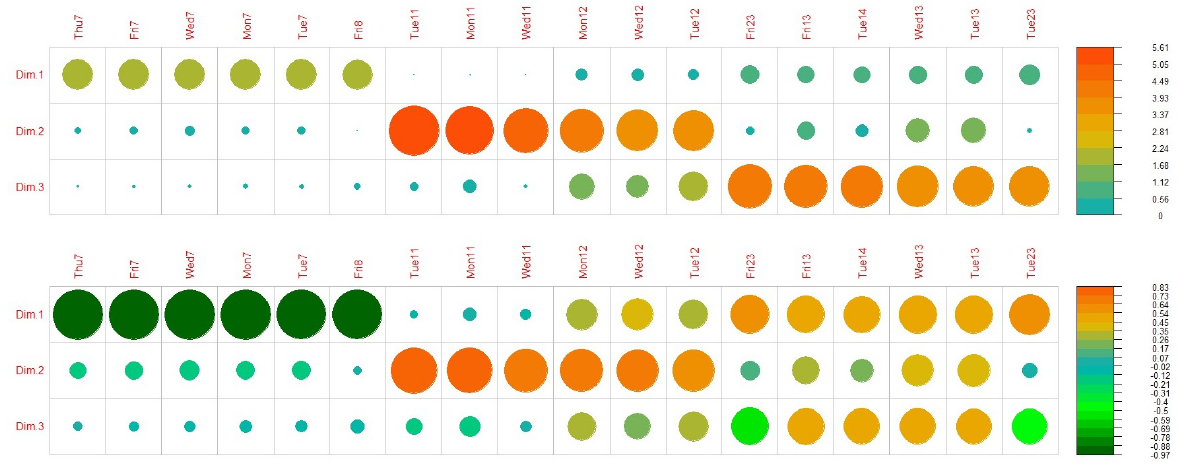
Figure 10. Contributions ( top ) and correlation ( bottom ) for the first three components.